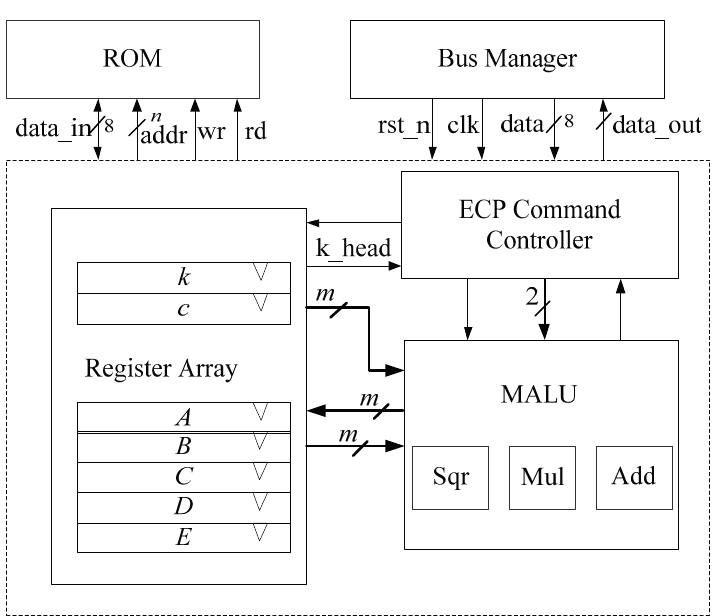
Figure 2. Structure of